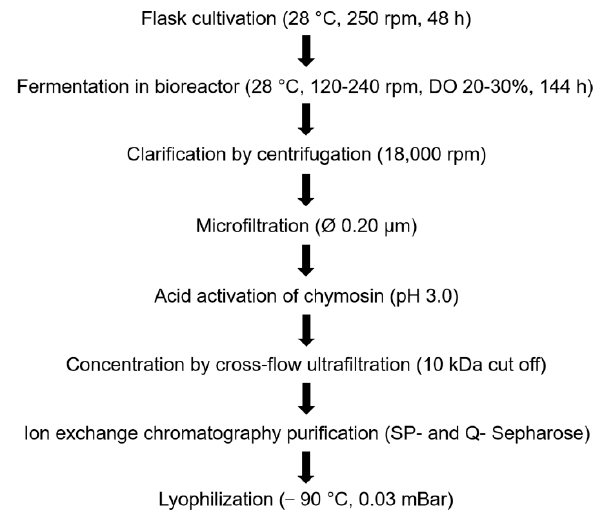
Figure 1. The workflow for obtaining the BacChym. DO: dissolved oxygen.